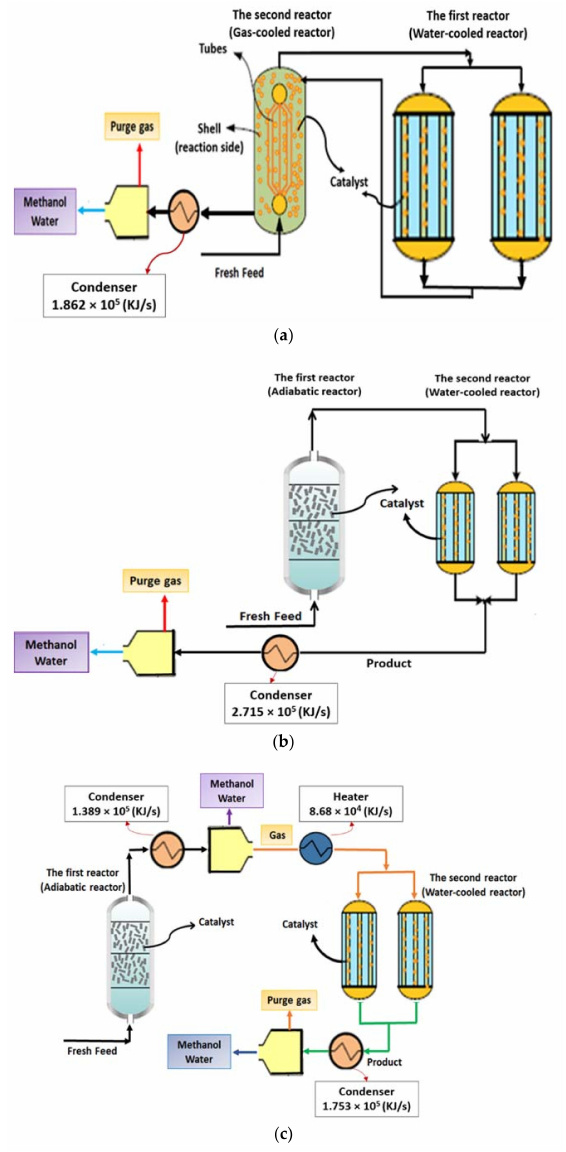
Figure 12. The schematic diagram of the energy requirement of ( a ) CR configuration; ( b ) AW configuration; and ( c ) ACW